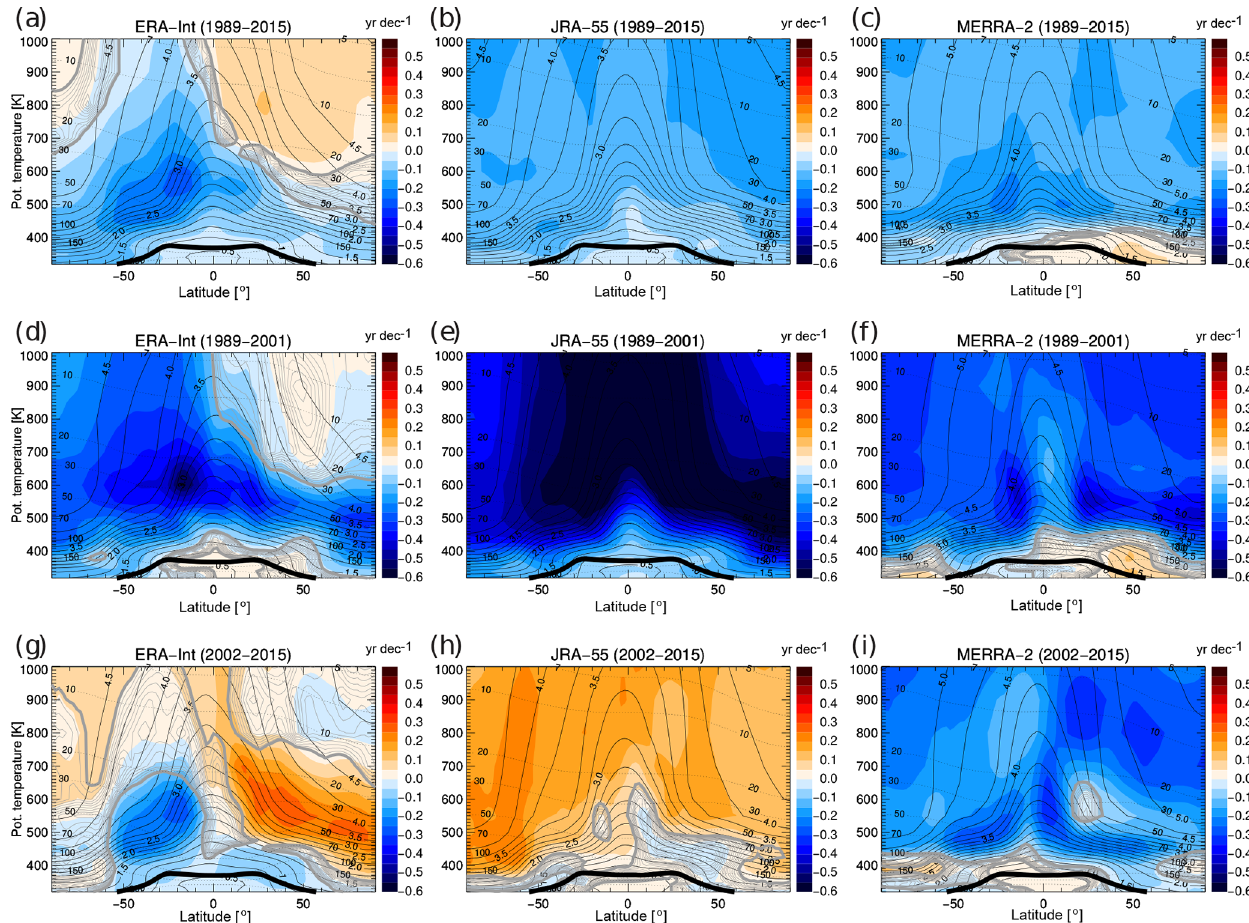
Figure 7. Long-term mean age trends for 1989–2015 (a, b, c) , decadal trends for 1989–2001 (d, e, f) and decadal trends for 2002–2015 (g, h, i) , for ERA-Interim (a, d, g) , JRA-55 (b, e, h) and MERRA-2 (c, f, i) . The trend significance, estimated in multiples of the standard deviation σ , is shown as grey contours (2 σ contour thick grey, and then decreasing in 0.2 steps as thin lines). The thin black solid contours show the climatological mean age distribution, the thin black dashed lines show pressure levels in hPa, and the thick black line is the (lapse rate)